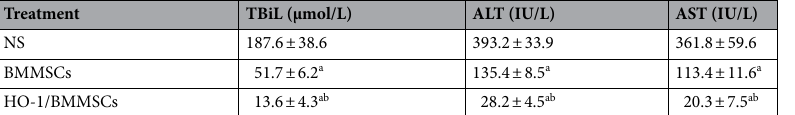
Table 2. The liver function of the recipients at 10 days after liver transplantation (mean ± SD, n = 5). a BMMSC group compared with NS group (P < 0.05). b HO-1/BMMSC group compared with BMMSC group(P < 0.05). ab HO-1/BMMSC group compared with control group (P < 0.01).